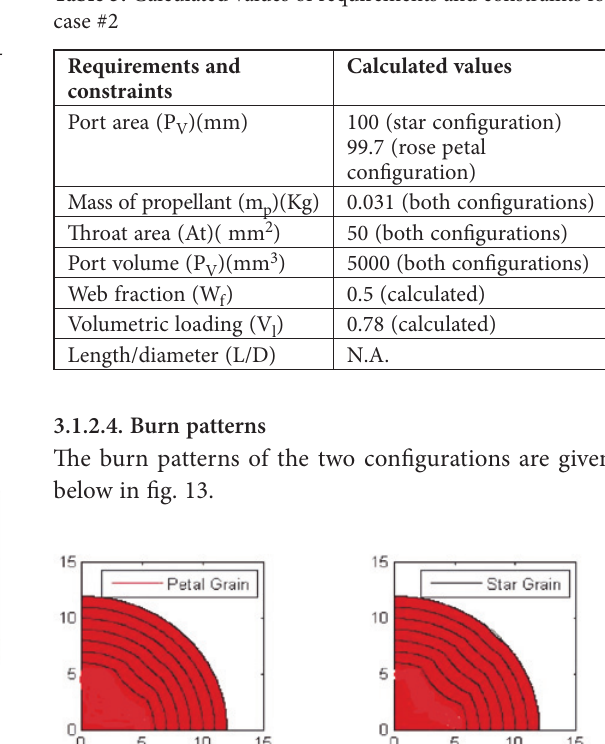
Fig. 10. Burn patterns of rose petal and star grain configurations